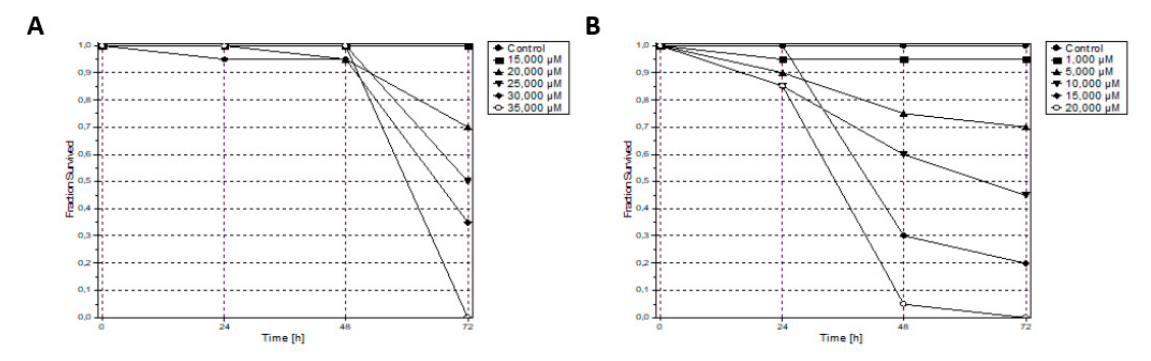
1 C.L Confidence limits; 2 NOEC (no observed effect concentration); 3 LOEC (lowest observed effect concentration). Figure 6. Accumulative mortality over (72 h) for complex Fe1 ( A ) and complex Fe2 ( B ) at the different stages evaluated (in